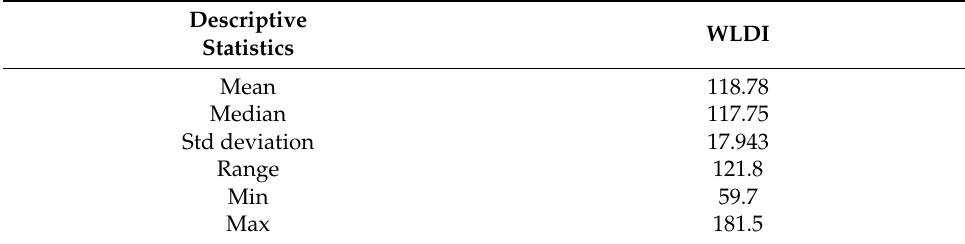
Table 5. Descriptive statistics of the results of complex indicators.